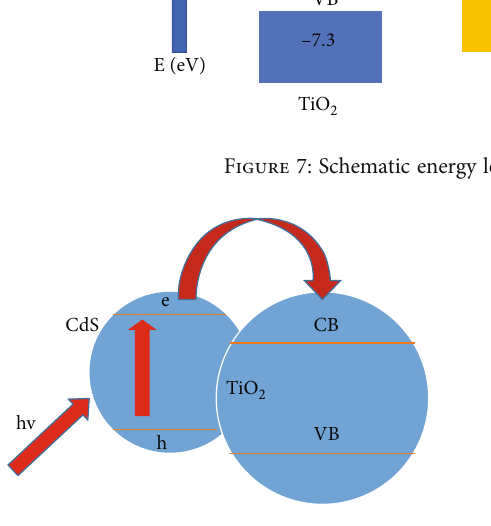
composite system. 2